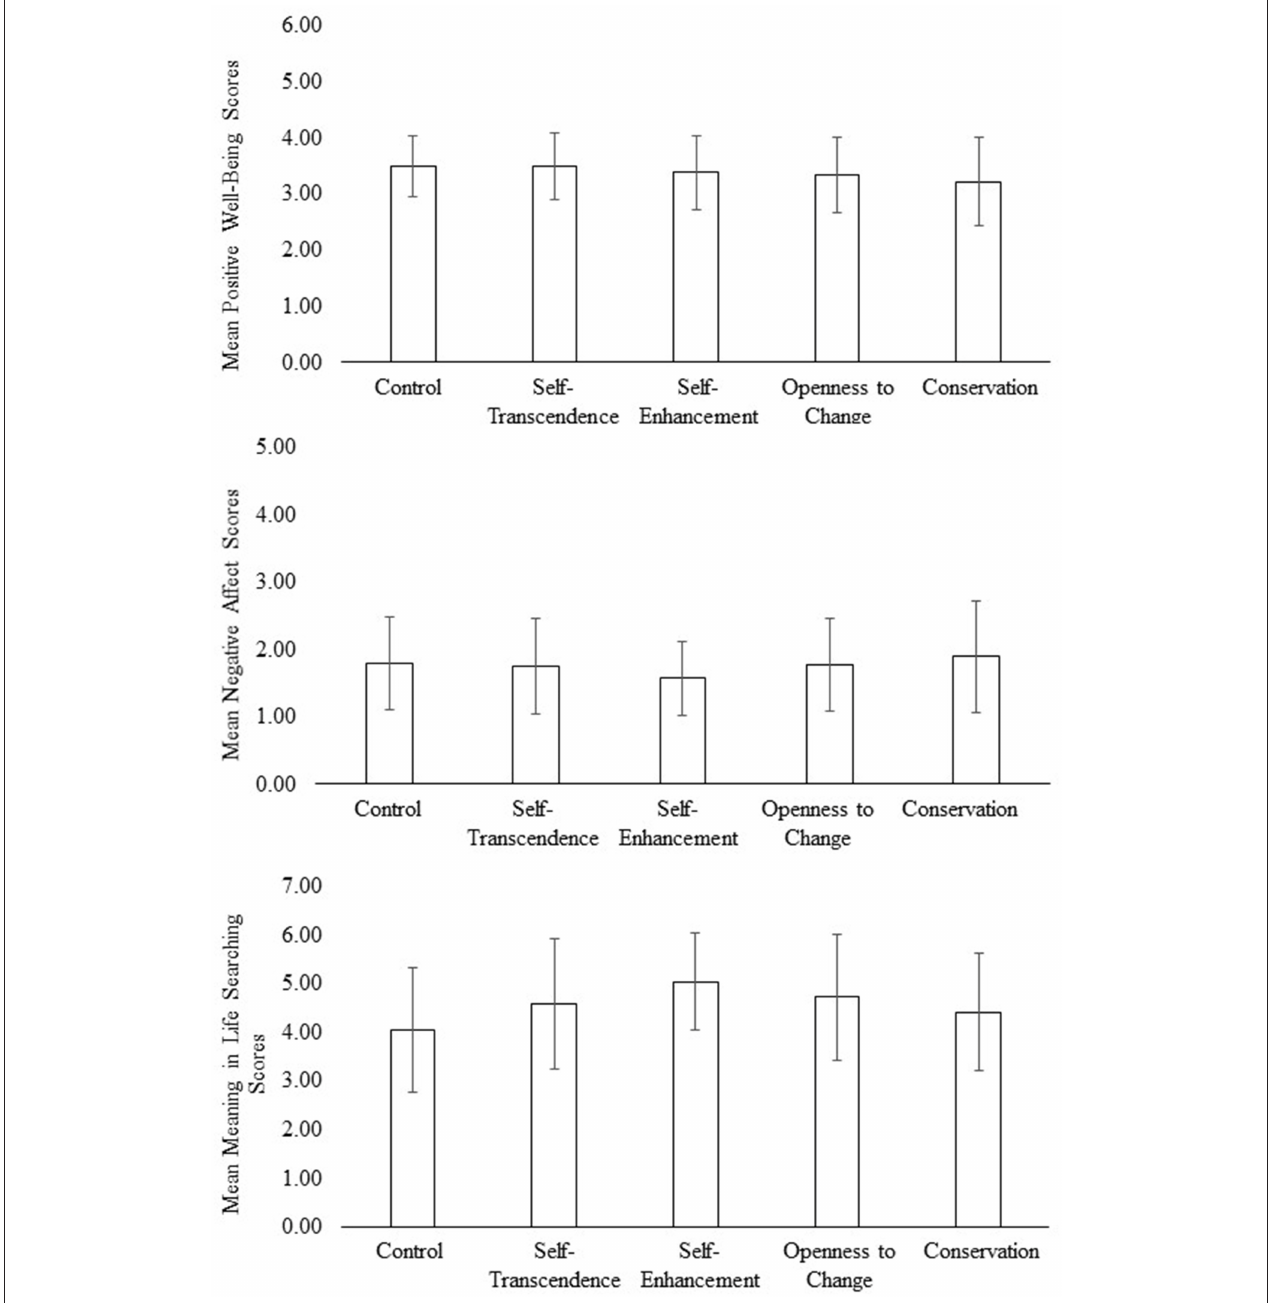
FIGURE 2 | Mean scores of Positive Well-being, Negative Affect, and Meaning in Life Searching across each of the experimental